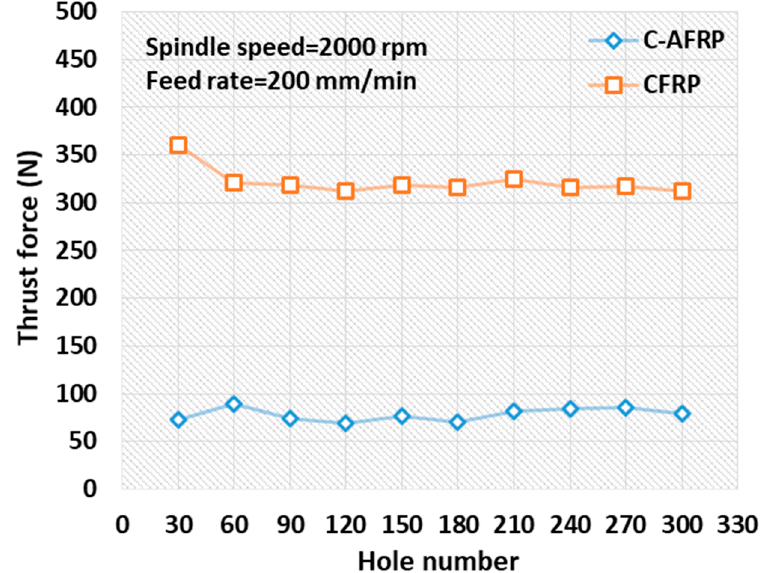
Figure 8. Burr formation in drilling of CFRP and C-AFRP.